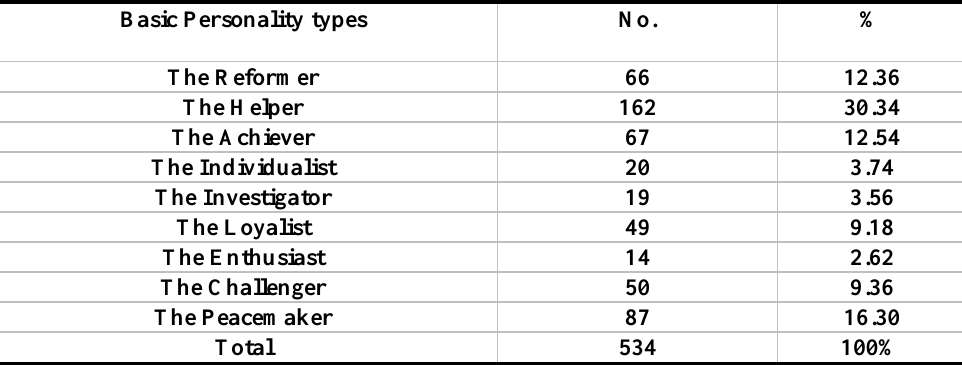
Table (1): The distribution of the teachers according to the Basic Personality Types Basic Personality